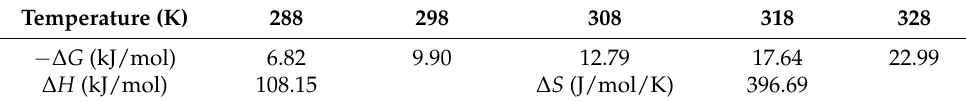
Table 2. Adsorption thermodynamic data for the adsorption of cesium ions.